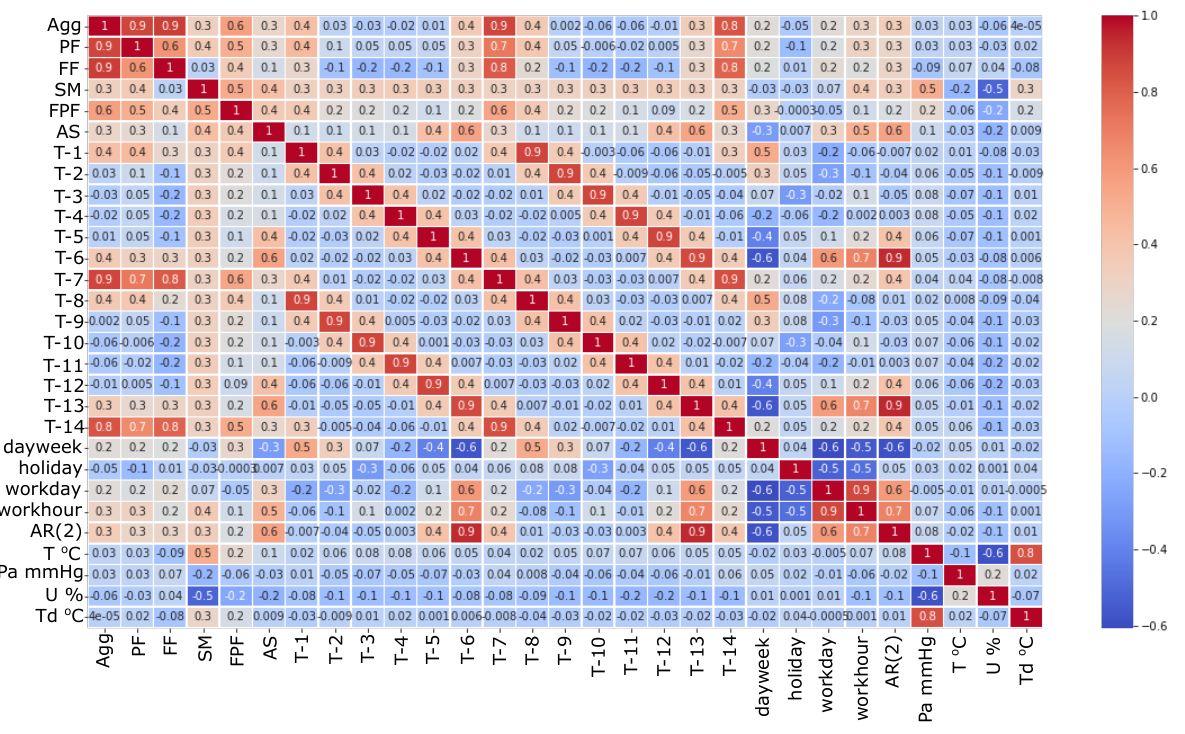
Figure 14. Auto regressive elements and exogenous variables used in